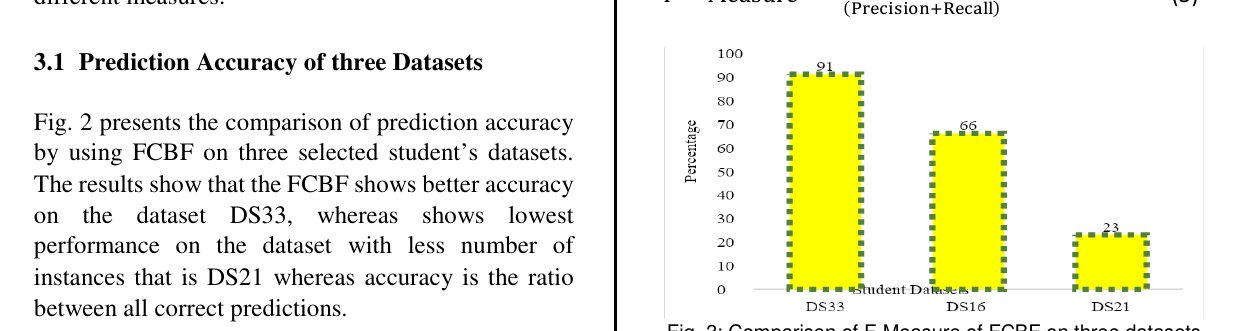
Fig. 3: Comparison of F-Measure of FCBF on three